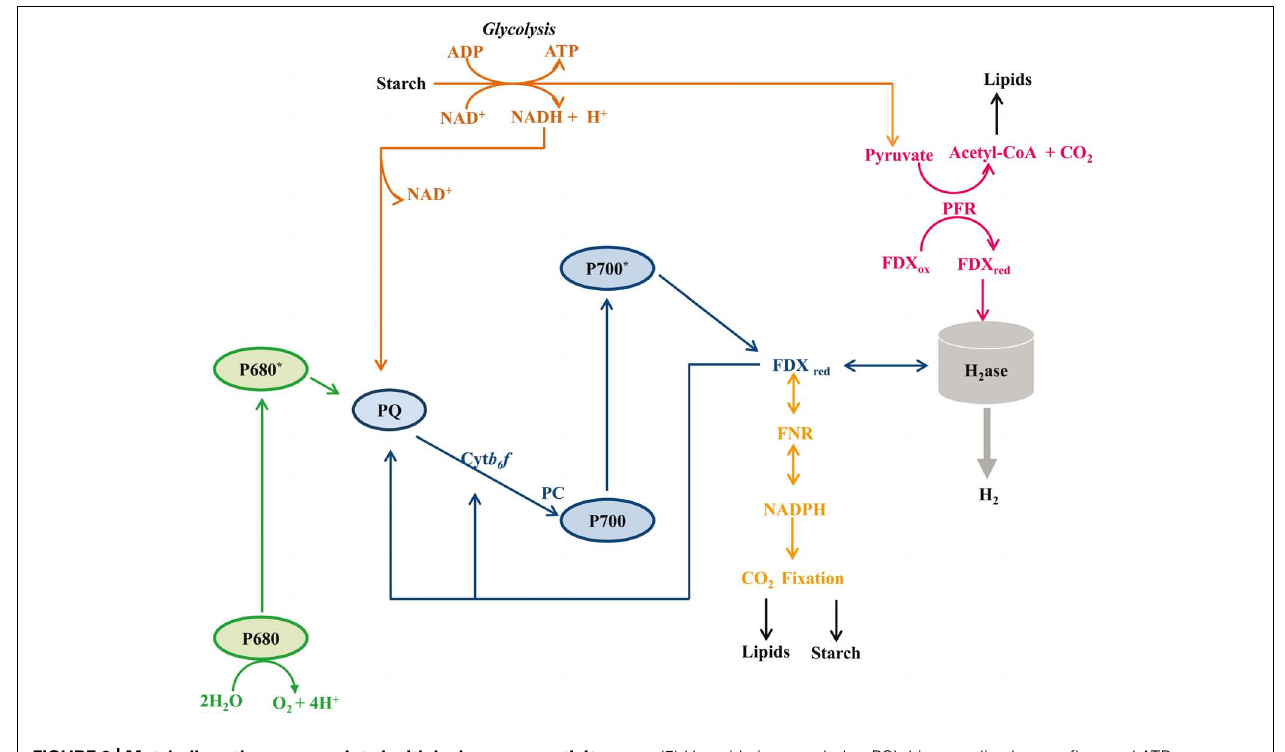
FIGURE 3 | Metabolic pathways associated with hydrogenase activity. Five distinct metabolisms are depicted: (1) H 2 production dependent on the complete photosynthetic electron transport system (PSII, PSI, FDX, H 2 ase; green and blue lines); (2) H 2 production requiring starch catabolism and PSI activity (starch, glycolysis, PQ, PSI, FDX, H 2 ase; brown and blue lines); (3) H 2 production in the dark from pyruvate oxidation (starch, glycolysis, pyruvate, FDX, H 2 ase; brown and magenta lines); (4) H 2 oxidation coupled to CO 2 reduction, with respiratory O 2 uptake used to generate ATP (H 2 , H 2 ase, FDX, FNR, NAD(P)H, CO 2 fixation; orange line);